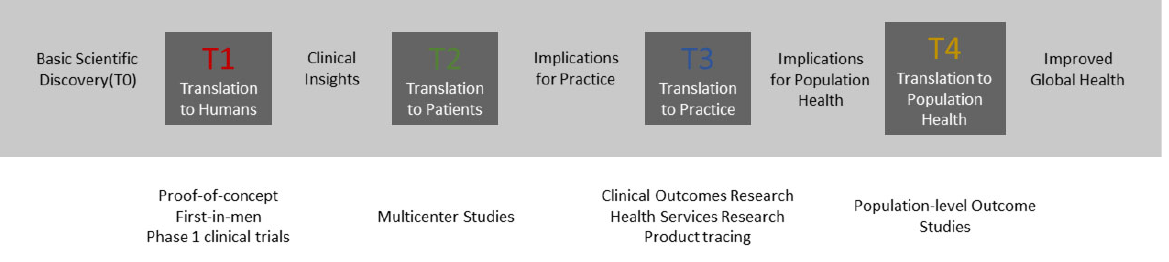
Figure 1. The process of translational research from basic scientific discovery to translation to population health [6].